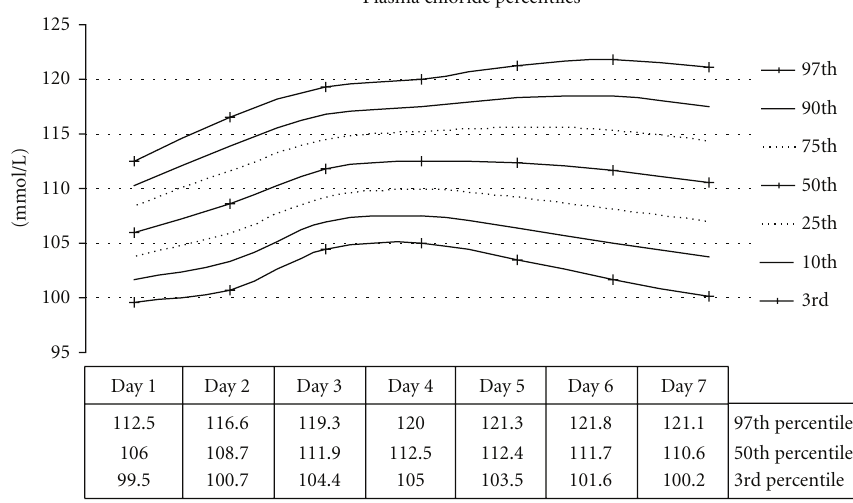
Figure 2: Plasma chloride percentiles during the first week of life in 107 infants < 33 weeks of GA hospitalized in NICU ( P value = 0.000001 at Kruskal-Wallis one-way analysis of variance).